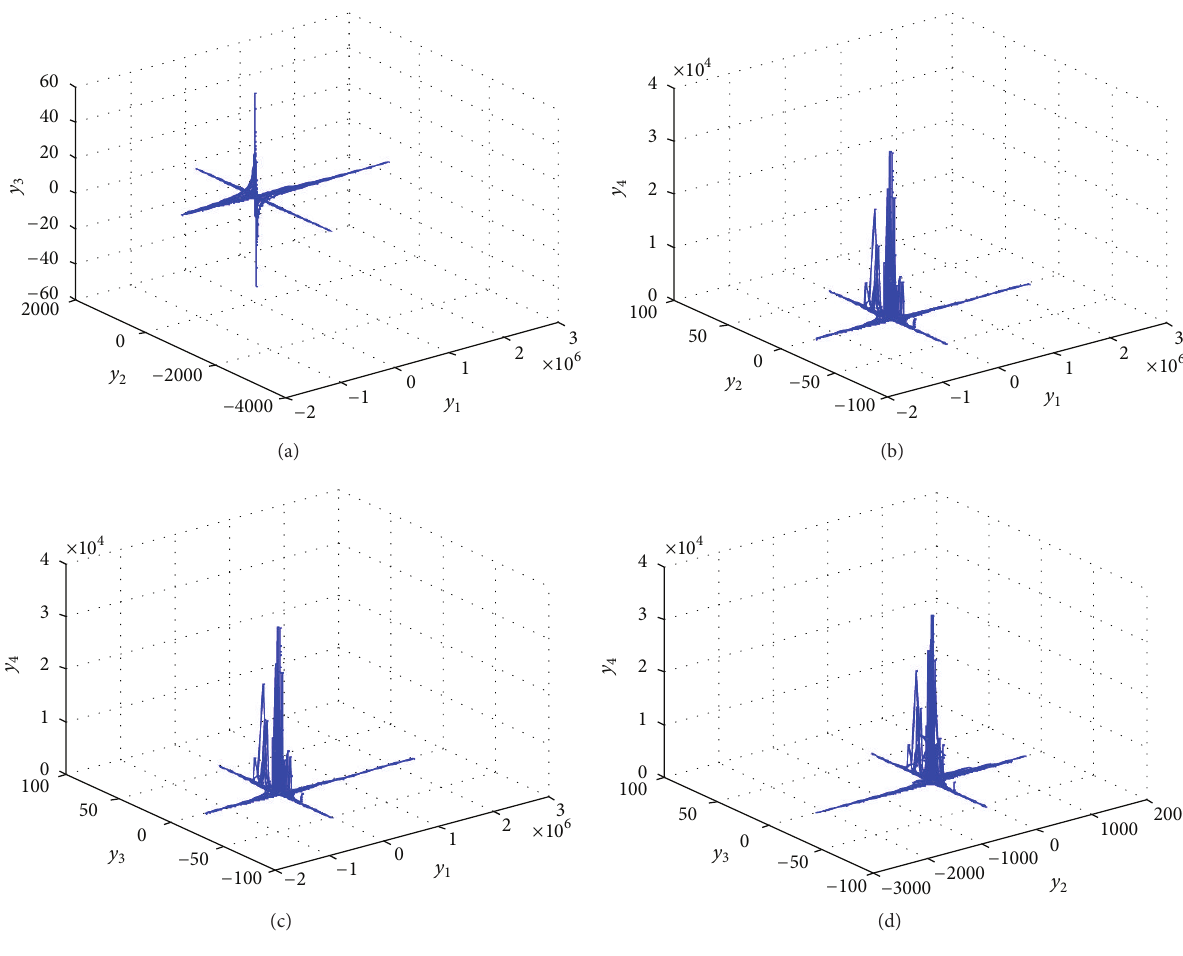
Figure 7: Projections of the phase portrait for chaotic system (13) of Case